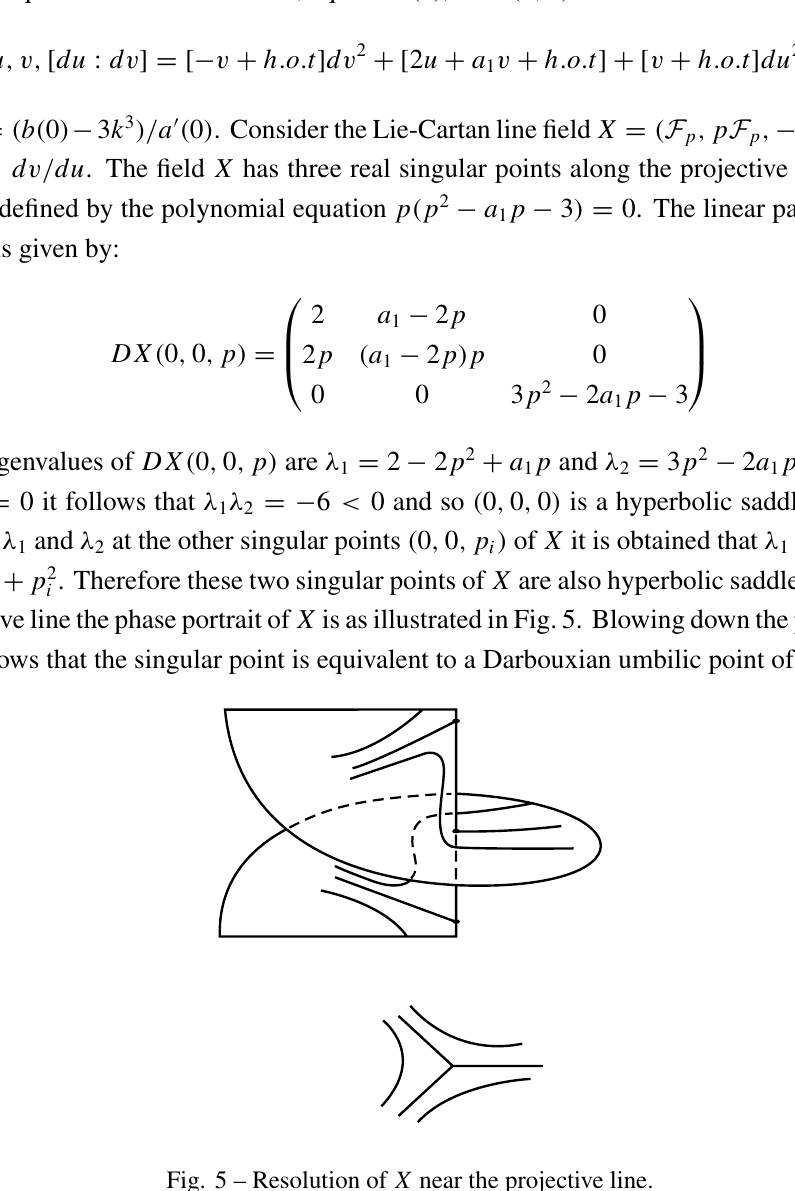
Fig. 5 – Resolution of X near the projective